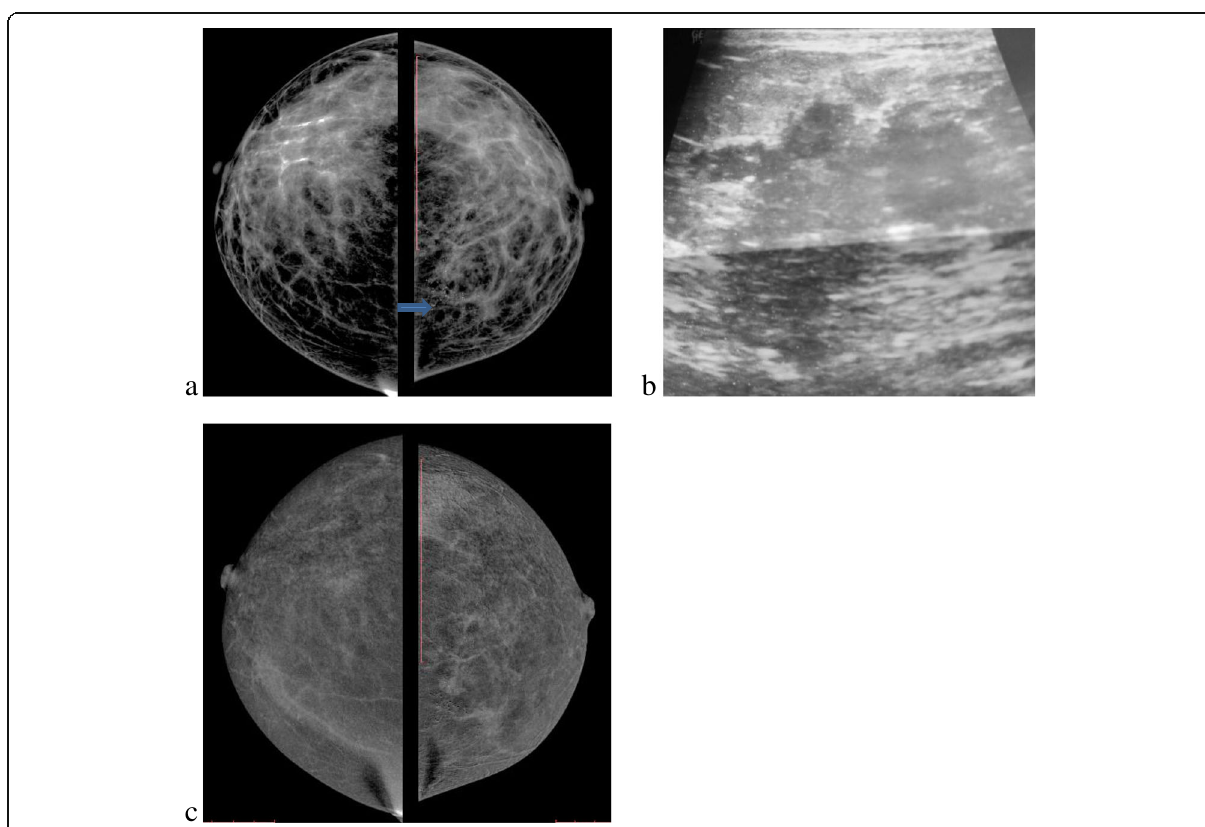
Fig. 4 A case of invasive duct carcinoma grade II showing in low energy image left focal asymmetry with suspicious calcifications ( a ). b Ultrasound shows an irregular mass lesion with superimposed microcalcifications. c Recombined image of CEDM shows two suspicious faintly enhancing mass lesions with irregular shape and speculated margins in the recombined